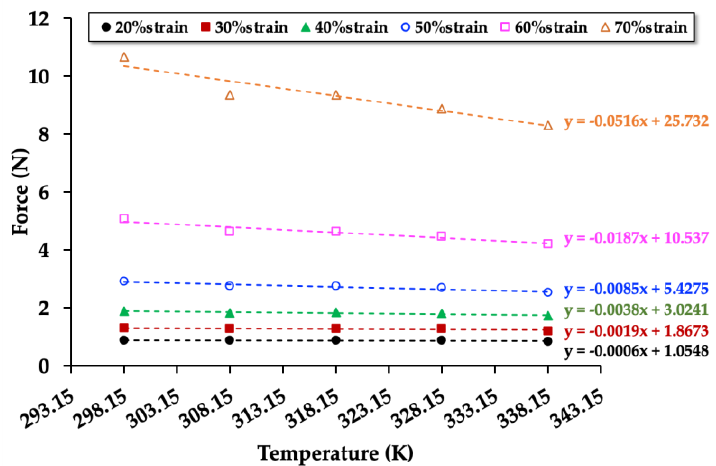
Figure 7. Force at a constant strain as a function of the temperature of the control NRF with a minimum of R 2 = 0.9 in each strain.